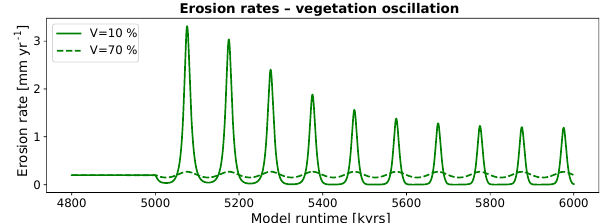
Figure 11. Predicted mean catchment erosion rates for simulations with oscillating surface vegetation cover and constant precipitation. Note that the magnitude of change in erosion rates for a ± 10% change in vegetation cover differs depending on the initial (or back- ground) vegetation cover. This nonlinear response is due, in part, to the vegetation cover effects on rock erodibility and diffusivity shown in Fig.